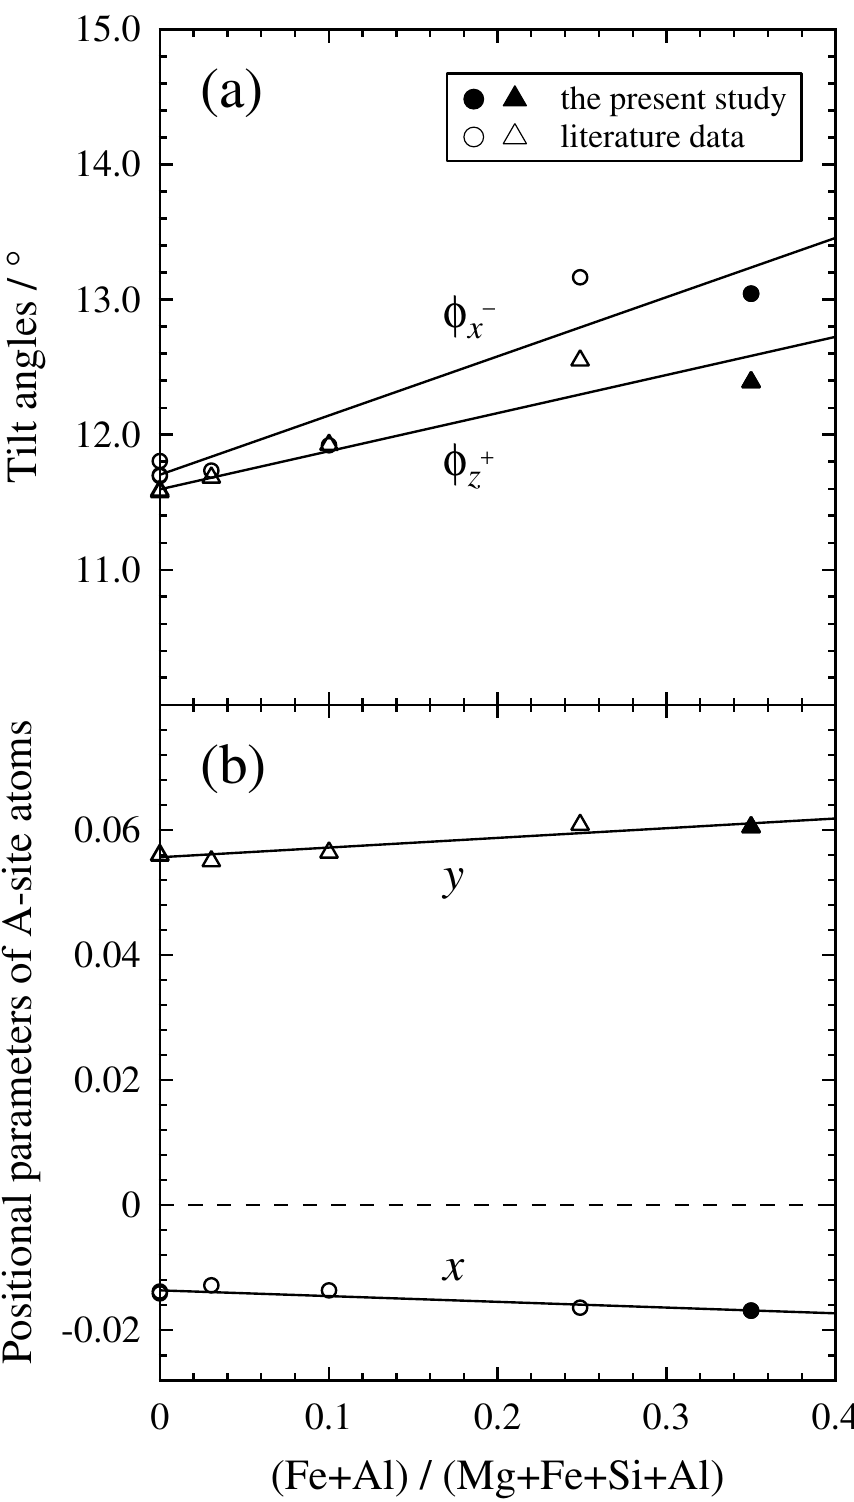
Figure 5. ( a ) Tilt angles φ − x (= φ − y ) and φ + z of BO 6 octahedra calculated from the symmetry-adapted mode approach 50 and ( b ) the positional parameters x and y of A-site atoms, located at the coordinates ( x , y , 0.25), as a function of the ratio (Fe + Al)/(Mg + Fe + Si + Al). The data calculated from the positional parameters reported in the end-member MgSiO 3 bridgmanite 44–46 and the (Fe, Al)-bearing bridgmanites 3 are plotted together with the present data. The data graphing software used is as in Fig.